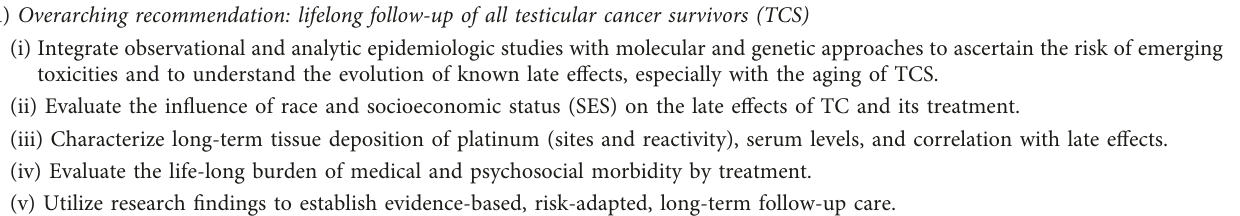
Figure 2: Proportion of testicular cancer survivors (TCS) with excellent, very good, good, fair, and poor self-reported health by number of adverse health outcomes (AHOs). P value for association of number of AHOs with self-reported health was test of trend). Self-reported health was not indicated by one participant with 1-2 AHOs and one participant with 3-4 AHOs. Table 4: Summary of major research recommendations: late effects of testicular cancer and its